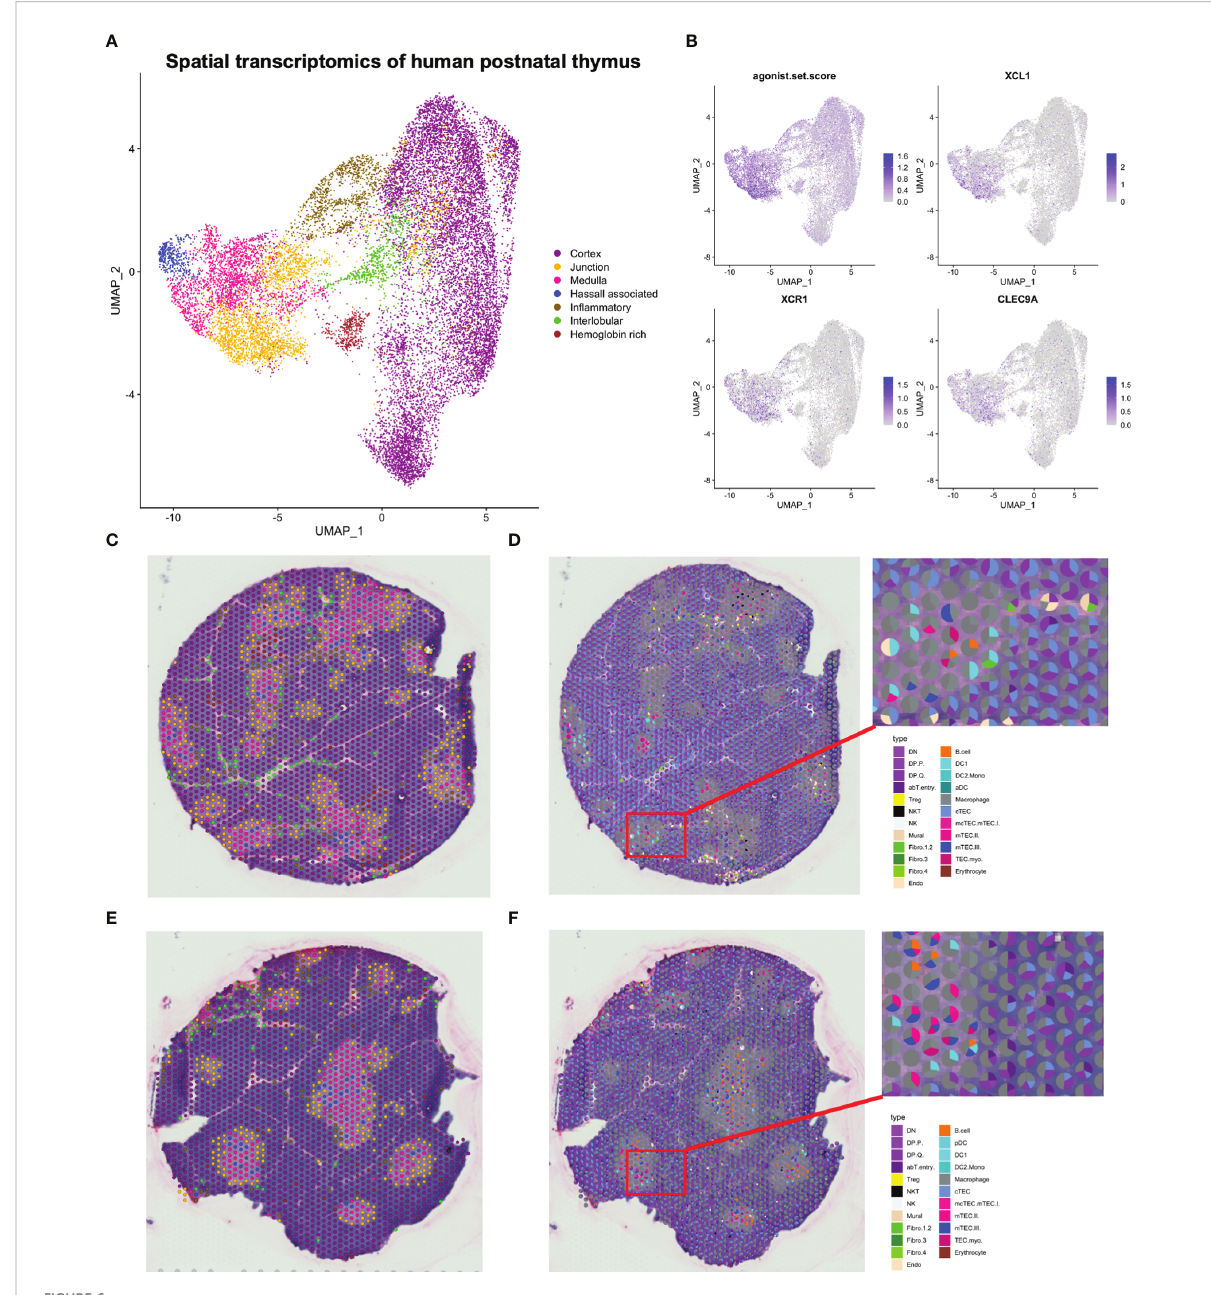
FIGURE 6 Spatial transcriptomics of human paediatric thymus. (A) UMAP of spatial transcriptomics dataset. (B) Expression of selected marker genes in spatial transcriptomics dataset. The agonist.set.score re fl ects the mean expression of NR4A1, NR4A3 , NFKBID, NFATC1, BCL2L11 and PDCD1. (C, E) Representative tissue sections coloured by annotations in (A) . (D, F) Spatial deconvolution of representative tissue sections by